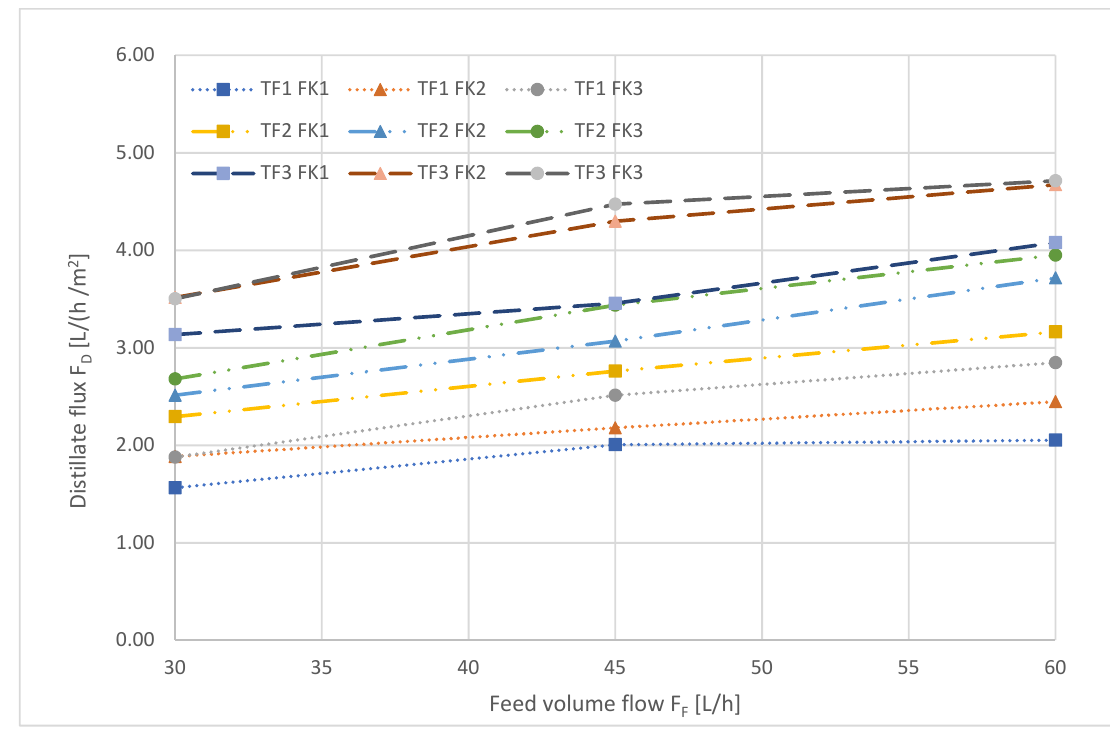
Figure 5. Distillate flux as a function of the feed volume flow (crossflow) during AGMD. The numbers refer to the different levels, low (1), medium (2), and high (3), described in Table 4.